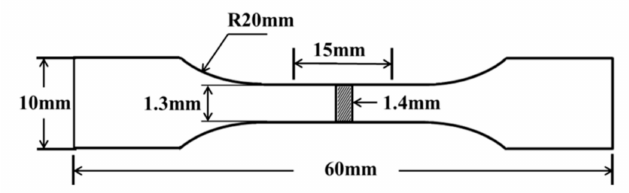
Figure 2. Schematic of tensile testing